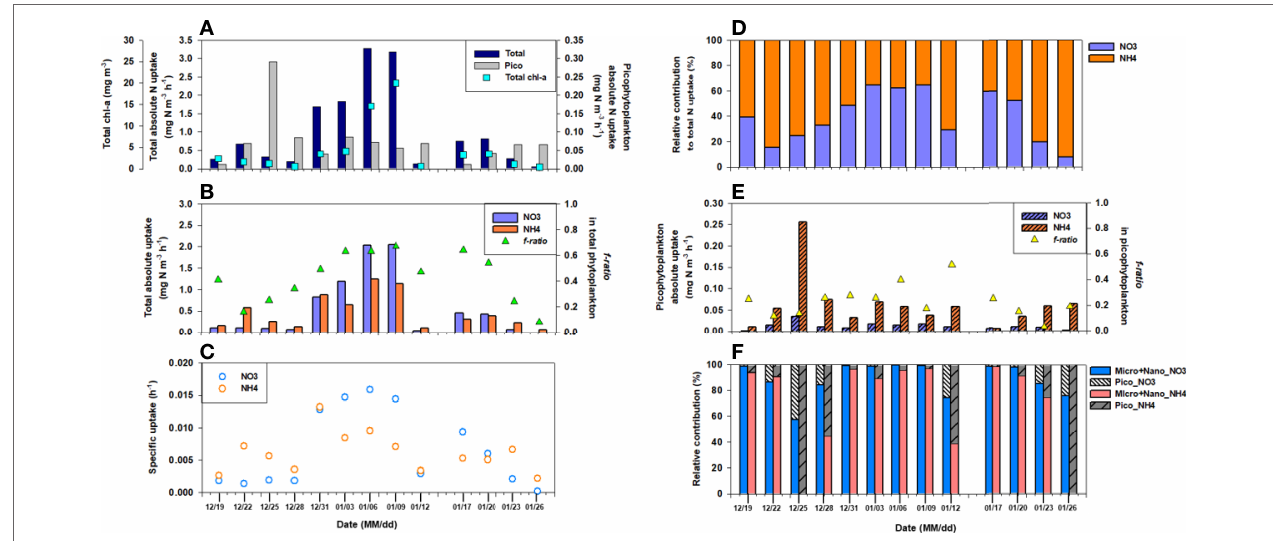
FIGURE 5 | Hourly rates of (A) nitrogen, (B) nitrate (NO 3- ) and ammonium (NH 4+ ) uptake, (C) specific nitrate (NO 3- ) and ammonium (NH 4+ ) uptake, and (D) the relative contribution of different N forms in total phytoplankton, (E) nitrate (NO 3- ) and ammonium (NH 4+ ) uptake in picophytoplankton, (F) the relative contribution of size-fractionated phytoplankton for different N forms on each sampling date. The blue squares in (A) and triangles in (B , E) represent total chl-a concentration and f -ratio,